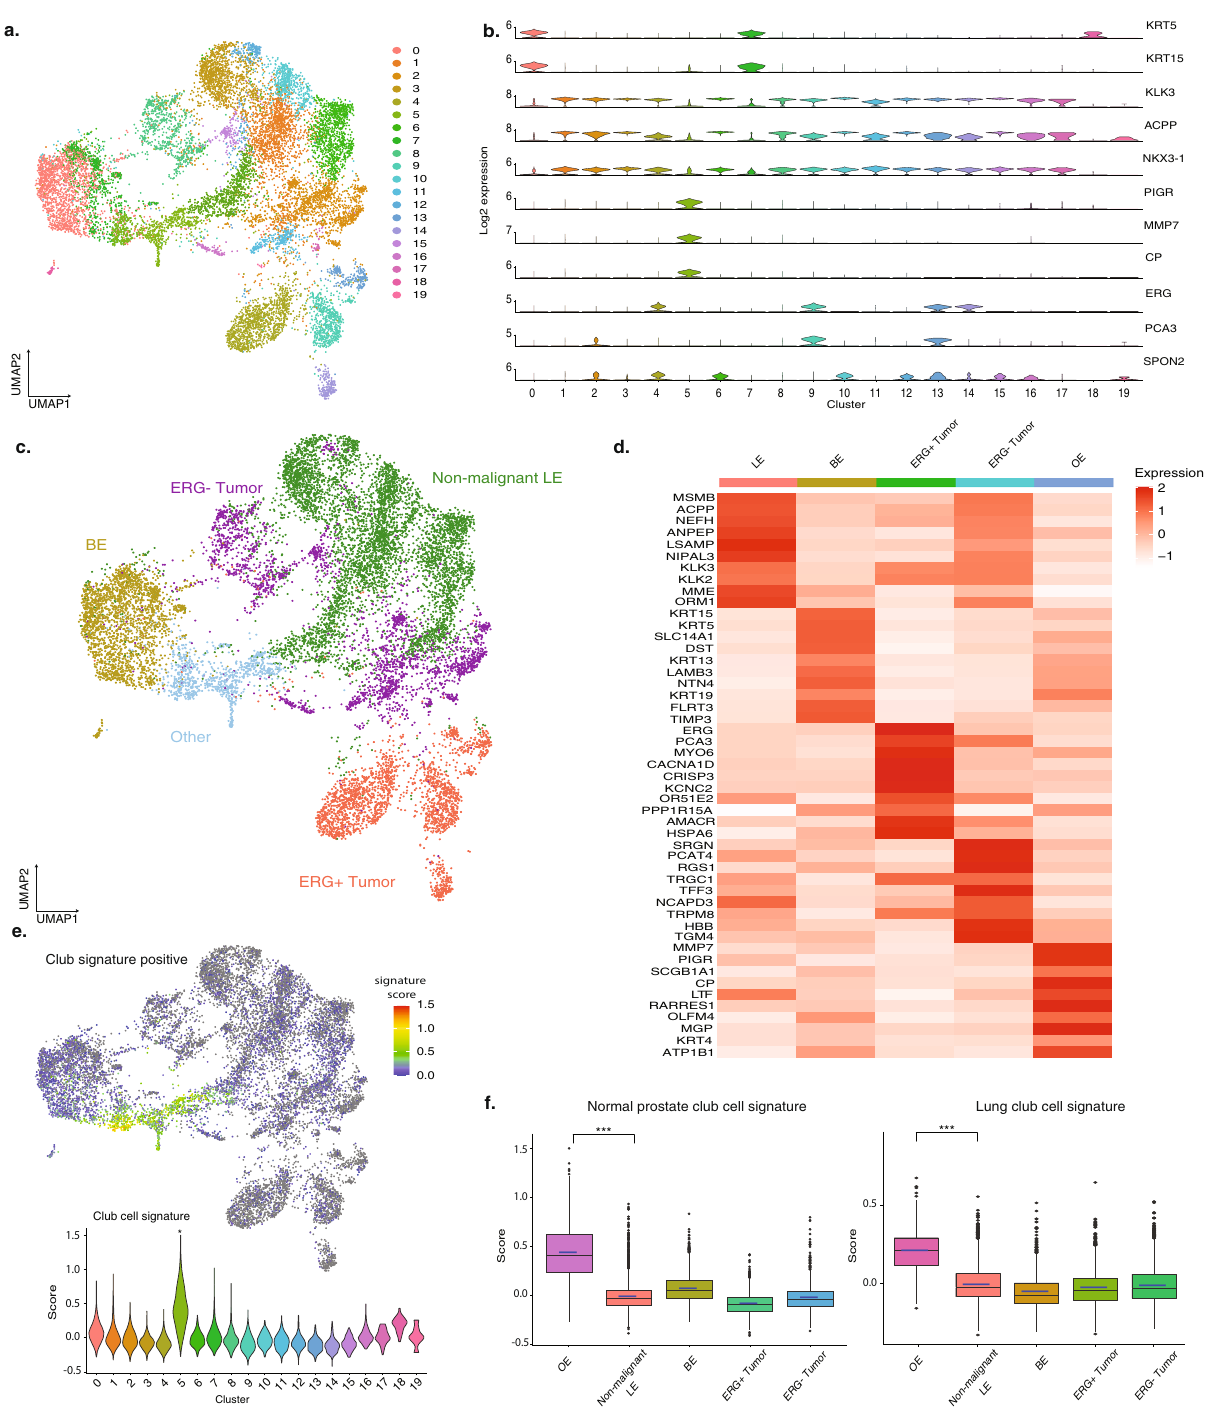
Fig. 2 Identi fi cation of tumor cells and major epithelial cell types, including club cells. a UMAP projection of all 20 clusters identi fi ed in the epithelial cells. Clusters are labeled in the UMAP. b Violin plots of representative marker genes across the clusters. c UMAP of epithelial cells annotated by cell types. d Heatmap of the top ten differentially expressed genes in each cell type (BE: basal epithelial cells; Other: other epithelial cells; Non-malignant LE: non-malignant luminal epithelial cells; ERG + Tumor: ERG + tumor cells; ERG − Tumor: ERG − tumor cells). e Club cell signature scores of each epithelial cell projected on the UMAP and signature score violin plots across all clusters. f Box plots of club cell signature scores from normal club cells and lung club cells across epithelial cell types ( N = 13,322 cells, *** P < 0.001, Wilcoxon rank-sum test; normal club cell signature: P < 2.2e-16; normal club cell signature: P < 2.2e-16). Center, bounds, and percentiles are shown in the box plot. Source data are provided as a Source Data fi